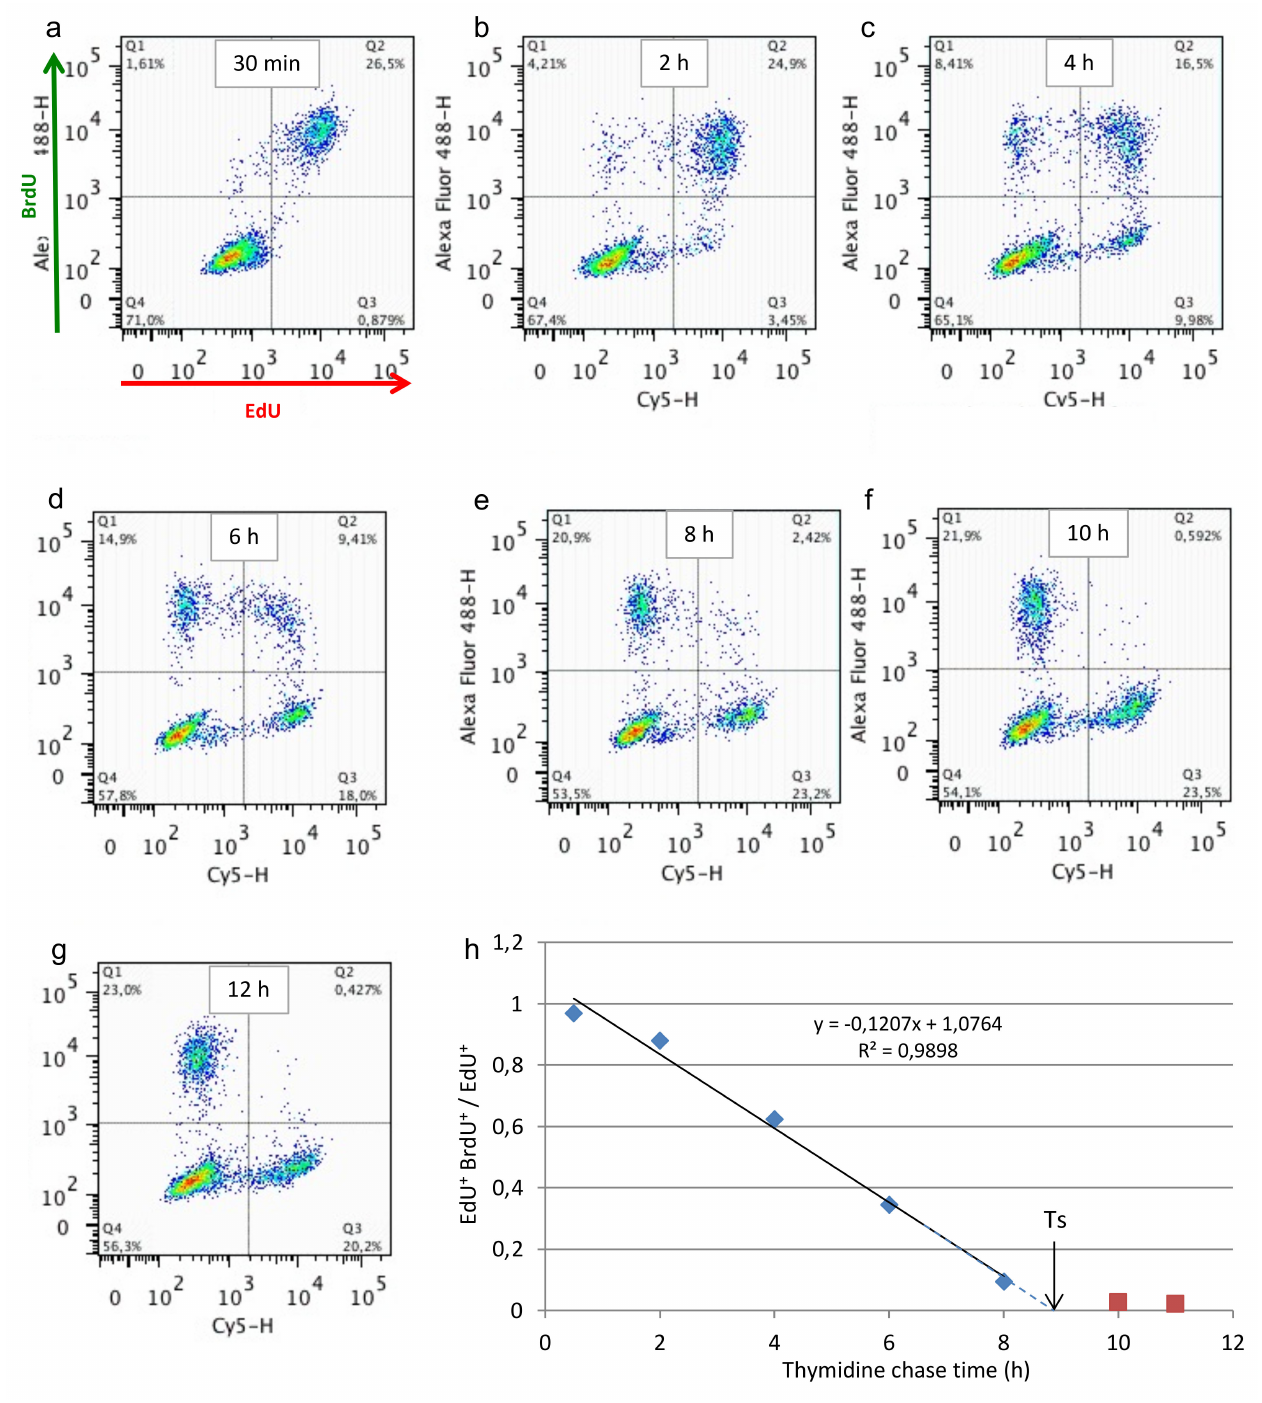
Figure 3. Asynchronous MEF cells were pulsed with 10 µ M EdU, then with 100 µ M BrdU (30 min each), either directly ( a ) or after a chase with thymidine and nocodazole of 1.5 h ( b ), 3.5 h ( c ), 5.5 h ( d ), 7.5 h ( e ), 9.5 h ( f ), and 11.5 h ( g ). Note double-positive cells (top right quadrant) decreasing over time. ( h ). Drawing a linear regression of the fraction of EdU + BrdU + cells amongst EdU + cells over time determines DNA synthesis time (T S or SPD) as the time when the regression line crosses the x